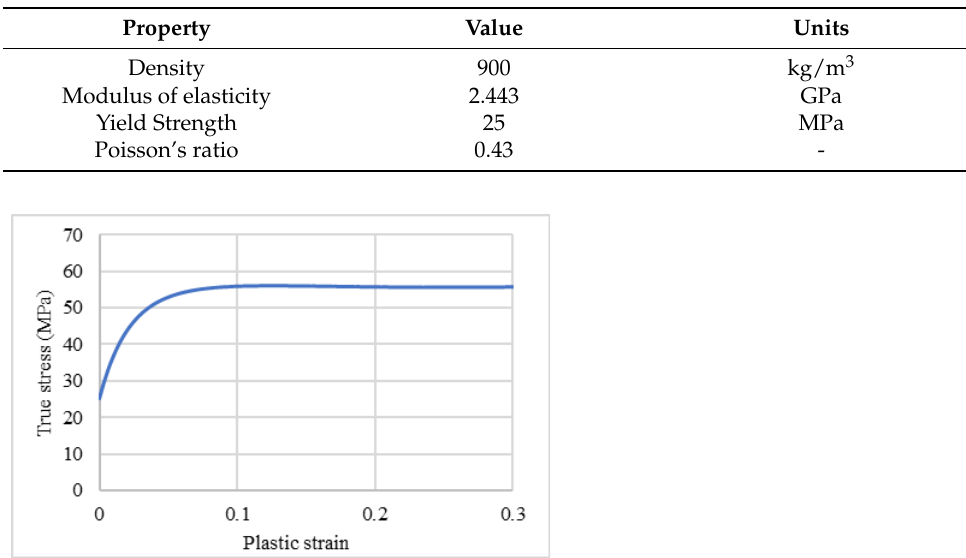
Table 3. Mechanical properties of polypropylene.